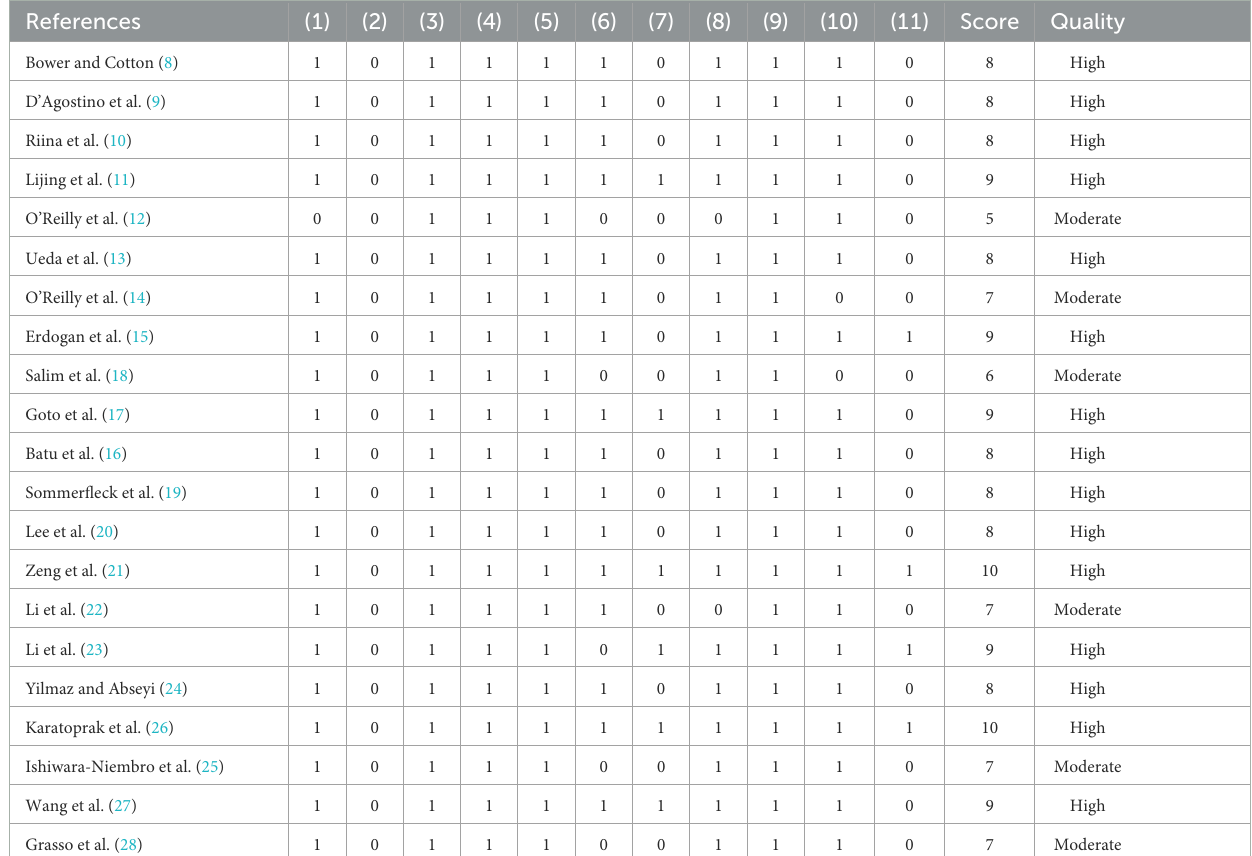
TABLE 2 Quality assessment of retrospective